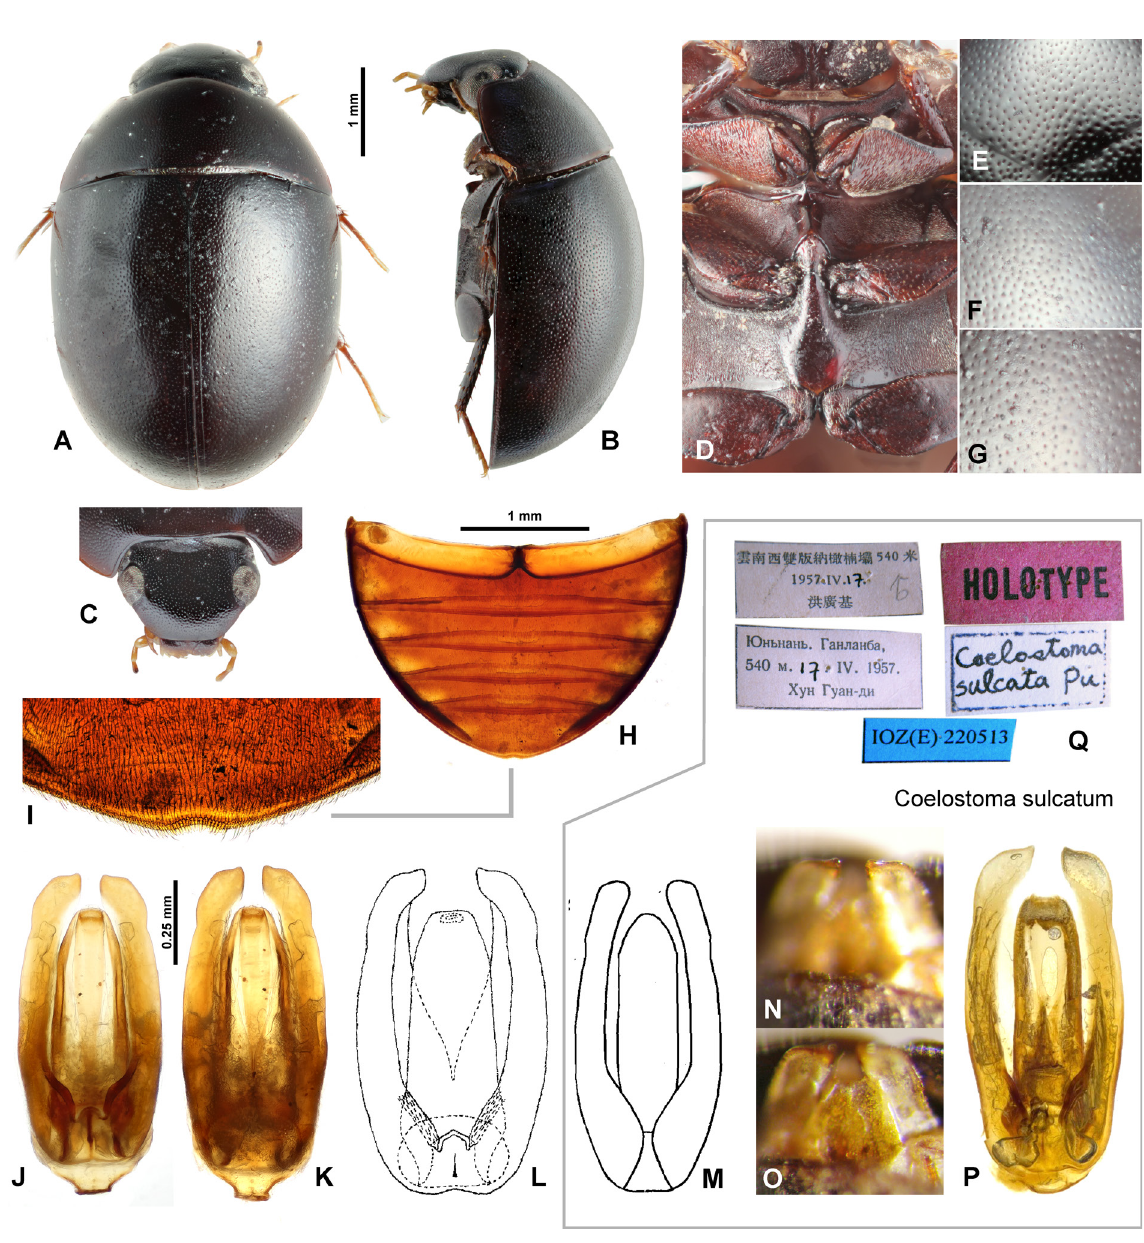
Fig. 9. Coelostoma ( Holocoelostoma ) bhutanicum Jayaswal, 1972 (A–L) and C. ( H. ) sulcatum Pu, 1963 (M–Q). A–K . C. bhutanicum , non-type specimen from India: Rajasthan, Alwar (NMPC). A . Dorsal habitus. B . Lateral habitus. C . Head. D . Thorax in ventral view. E . Dorsal punctation of head. F . Dorsal punctation of pronotum. G . Dorsal punctation of elytron. H . Abdominal ventrites. I . Detail of abdominal apex. J–K . Aedeagus: dorsal (J) and ventral (K). L . Illustration of the aedeagus of the paratype of C. bhutanicum by Jayaswal (1972). M . Aedeagus illustration from the description of C. sulcatum in Pu (1963). N–O . Apex of the aedeagus of the holotype of C. sulcatum . P . Aedeagus of the paratype of C. sulcatum from Yunnan: Jingdong. Q . Labels of the holotype of C. sulcatum